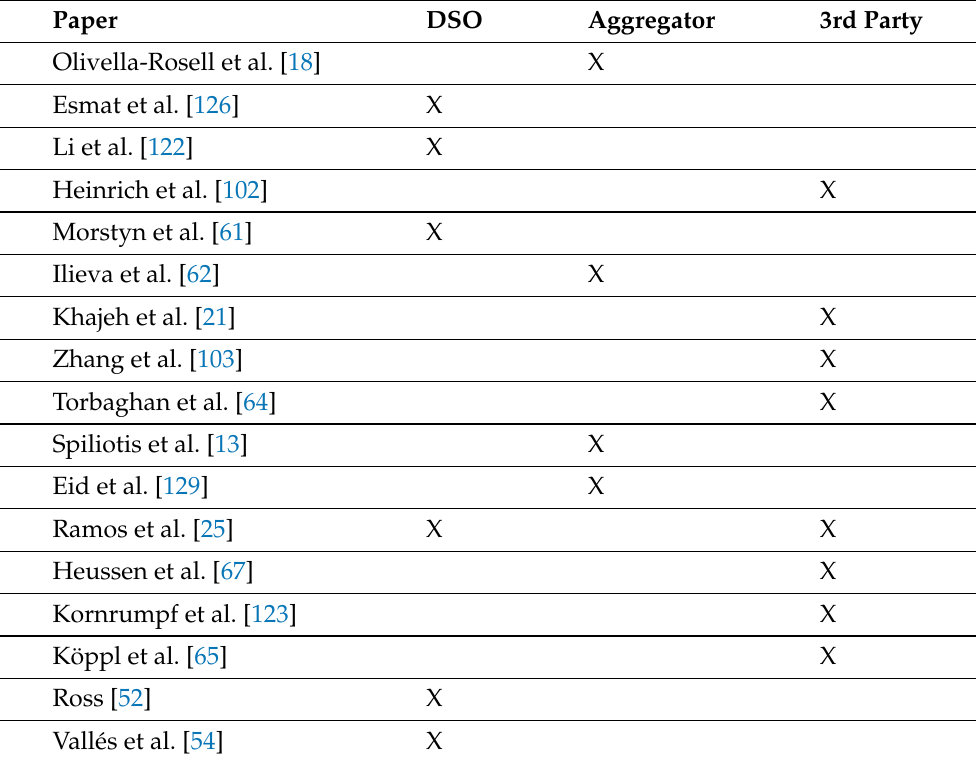
Table 2. The assigned Local FMO in various